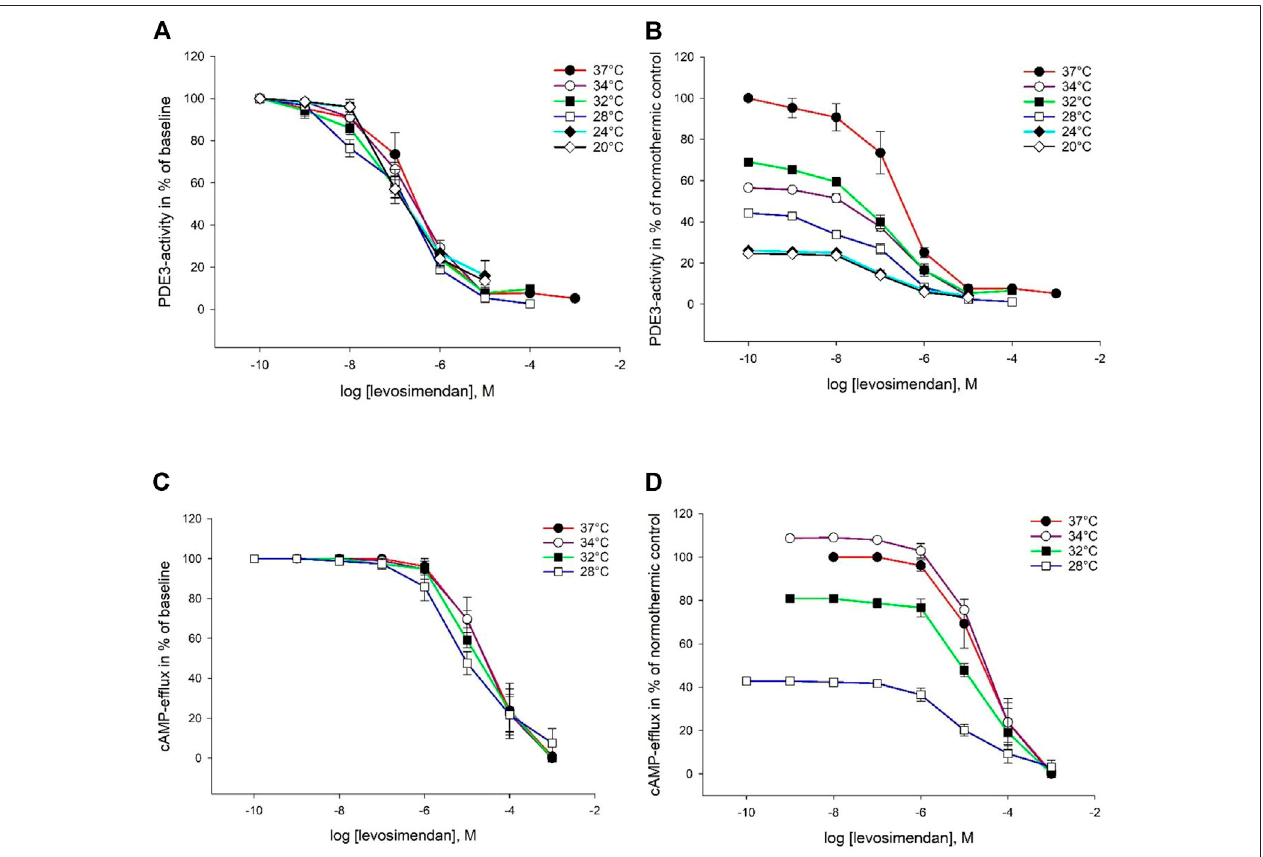
FIGURE 4 | Temperature-dependent inhibition of PDE3 and cAMP-ef fl ux by levosimendan. The does are in logarithm of the concentration in mol/L, presented as means ± SEM. (A) Inhibition curves for PDE3-activity at temperatures ranging from 37 ° C to 20 ° C. (B) Inhibition curves for PDE3-activity in % of normothermic inhibition curve at temperatures ranging from 37 ° C to 20 ° C. (C) Inhibition curves for ABCC4-activity at temperatures ranging from 37 ° C to 20 ° C. (D) Inhibition curves for ABCC4- activity in % of normothermic inhibition curve at temperatures ranging from 37 ° C to 20 ° C.